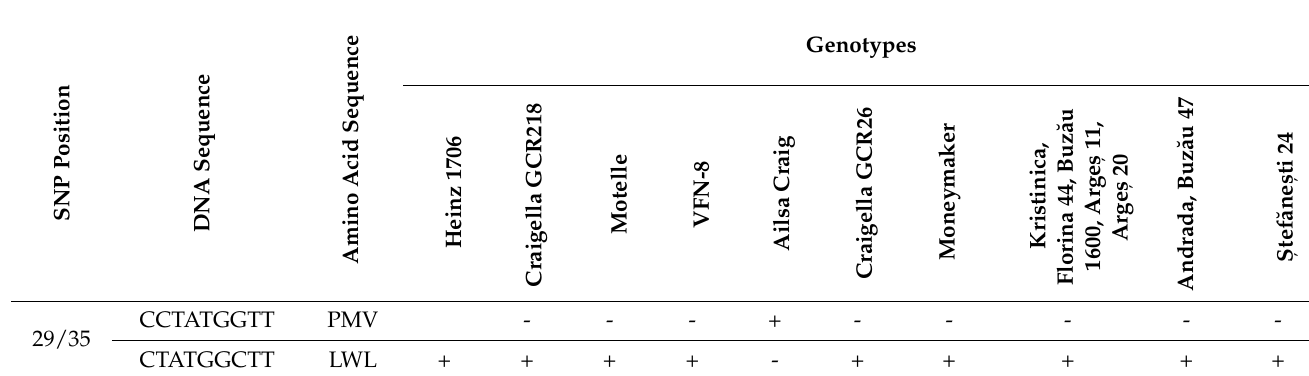
Table 1. Sequence analysis of the Ve1